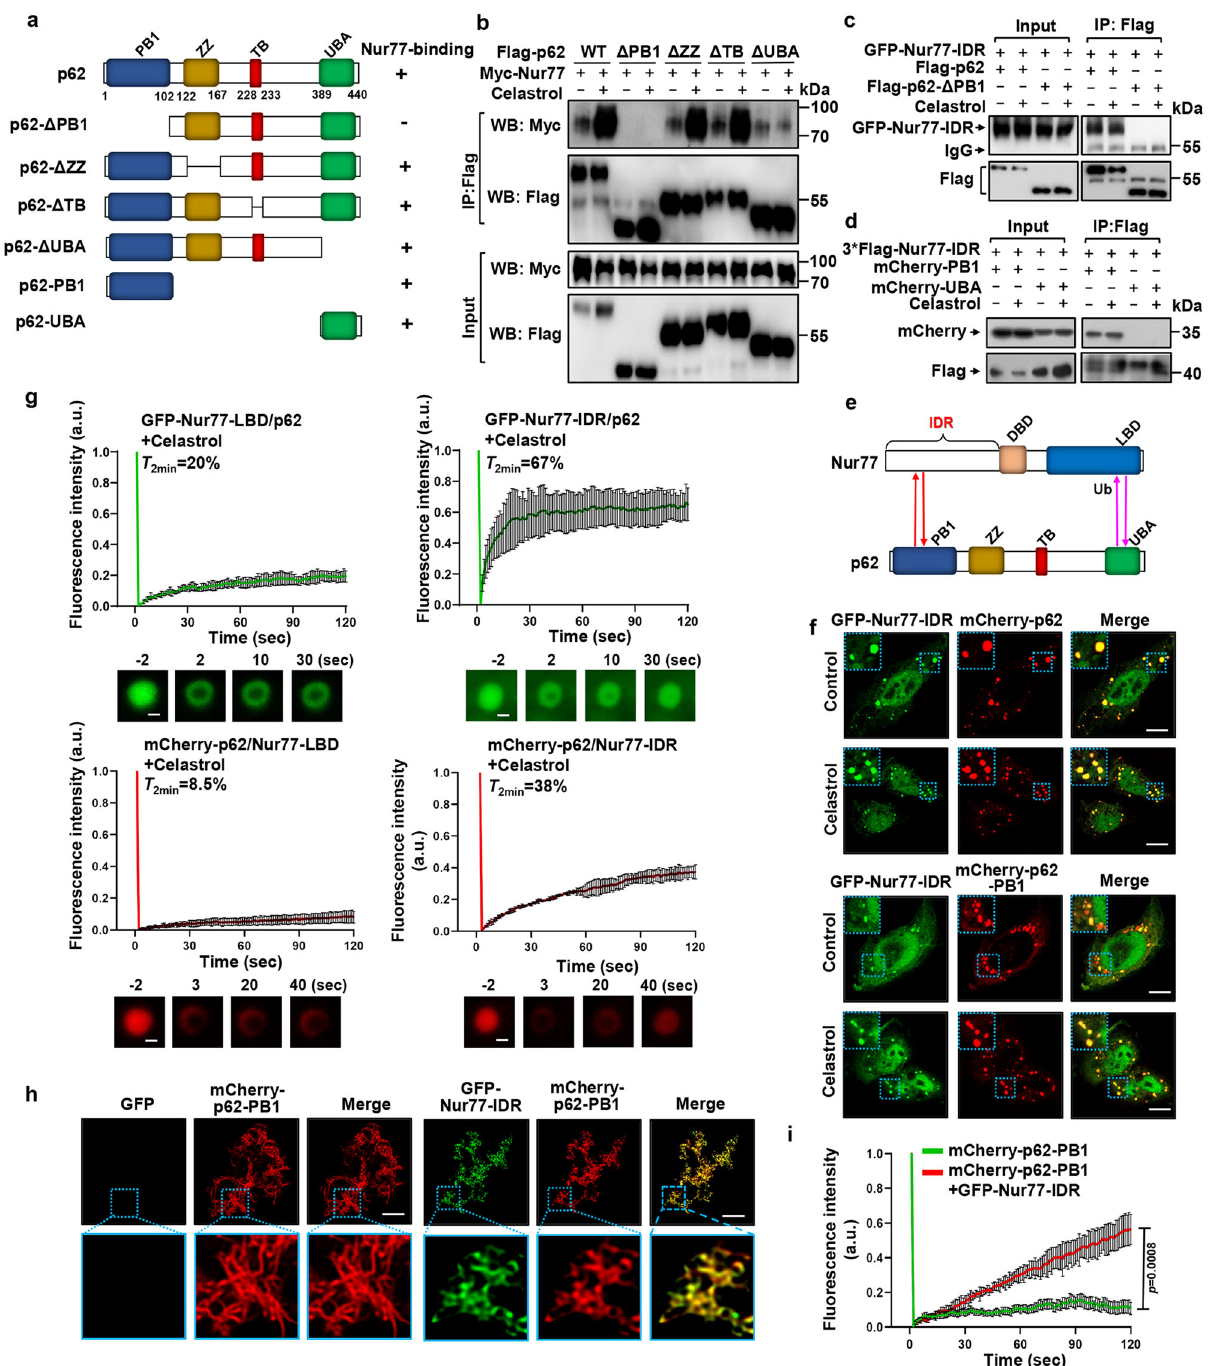
Fig. 7 IDR interaction with PB1 promotes liquidity of p62 condensates. a Schematic representation of p62 and mutants and their interaction with Nur77. PB1 Phox/Bem1p protein-protein binding domain. ZZ zinc- fi nger domain, TB TRAF6 binding domain, UBA ubiquitin-associated domain. b – d Interaction of Nur77 and p62, as well as their mutants, was analyzed in HeLa cells treated with or without celastrol by co-IP assay. e Multivalent interaction between Nur77 and p62. The interaction between the IDR of Nur77 and PB1 of P62 is ligand-independent (red), whereas the interaction between LBD of Nur77 and UBA of p62 depends on celastrol that triggers Nur77-LBD ubiquitination (pink). f Immuno fl uorescence images showing colocalization of GFP-Nur77-IDR with mCherry-p62 or mCherry-p62-PB1 after treatment with or without celastrol. Scale bar, 10 μ m. g FRAP analysis of the effect of Nur77-IDR in regulating p62 mobility in HeLa cells. Data were presented as mean values ± SEM ( n = 3 independent experiments). Scale bar, 1.5 μ m. h Representative images showing the effect of GFP-Nur77-IDR on the fi lamentous structures of mCherry-p62-PB1 when mCherry-p62-PB1 was incubated with GFP or GFP-Nur77- IDR at intermediate molar ratio (1:2). Scale bar, 10 μ m. i FRAP analysis of the effect of GFP-Nur77-IDR on mCherry-p62-PB1 mobility in vitro. Two-tailed unpaired Student ’ s t -test was used for statistical analysis, and data were presented as mean values ± SEM ( n = 3 independent experiments). Data represent at least three independent experiments. Source data are provided as Source Data fi